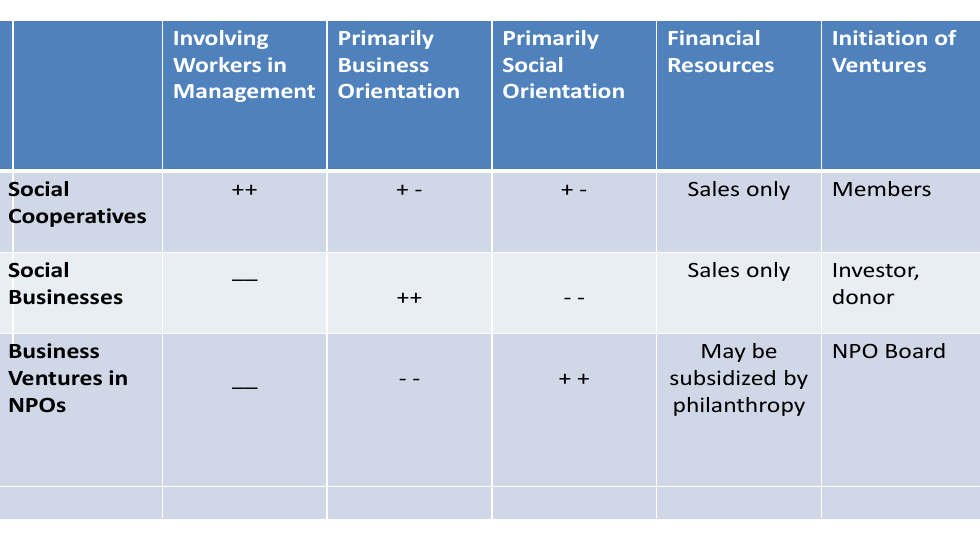
Market ‐ Driven Social Ventures by Type and Select Organizational